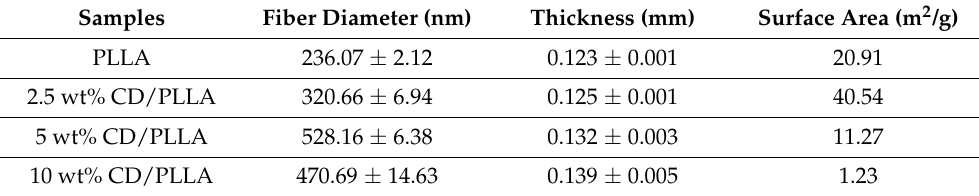
Table 1. Fiber diameter, thickness, and surface area of PLLA and CD/PLLA nanofibers.